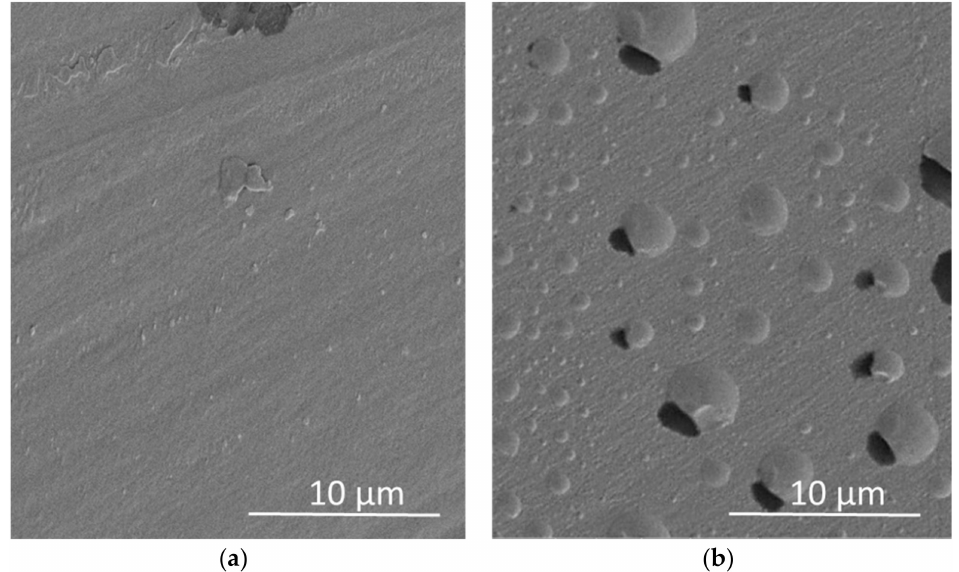
Figure 7. SEM images of the polymer before ( a ) and after ( b ) impregnation. The extract and fraction impregnated polymers obtained at 200 bar, 35 ◦ C, 3 h, and 1% ethanol as cosolvent were evaluated in terms of antimicrobial capacity against S. aureus , showing an inhibition of 76.04% ± 4.27 and 69.77% ± 3.25